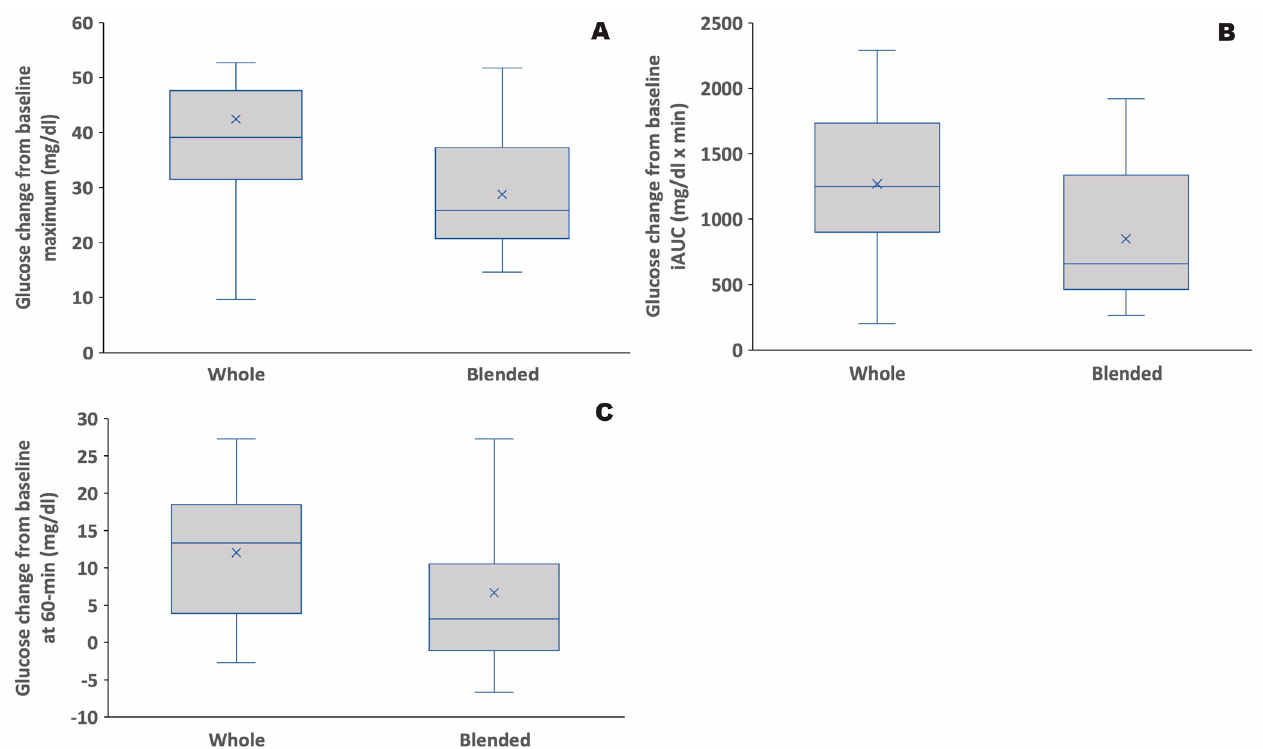
Figure 2. Glycemic response variables subtracted from baseline glycemic values from 20 participants after consuming whole fruit versus blended fruit, represented by ( A ) glucose maximum, ( B ) glucose incremental area under the curve (iAUC), and ( C ) incremental glucose at 60-min. Whole vs. blended fruit were significantly different ( p ≤ 0.05) in plots ( A , B ) and were marginally significantly different ( p = 0.057) in plot ( C ). Vertical bars illustrate maximum and minimum values, the top and bottom of the box represent third quartile and first quartile values, respectively, the line inside the box represents the median, and the “×” represents the mean.